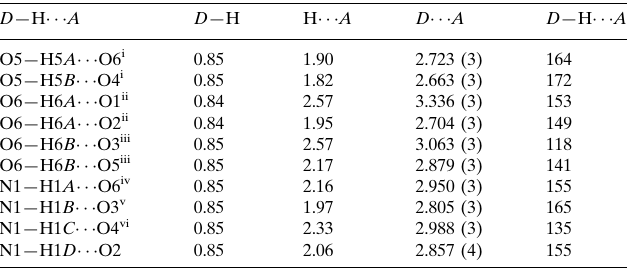
features a six-coordinate Co atom located on a center of symmetry. The octahedral O coordination geometry is 6 defined by two bidentate malonate ligands and two water molecules, with the latter in a trans configuration. The molecules are linked through O—H (cid:1) (cid:1) (cid:1) O and N—H (cid:1) (cid:1) (cid:1) O hydrogen-bonding interactions, forming a three-dimensional supramolecular network. Related literature